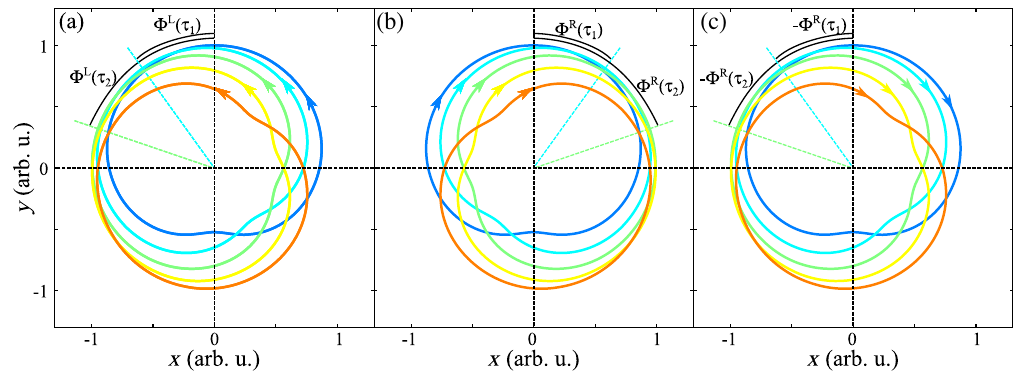
FIG. 8. Evolution of a bicircular field with intensity ratio r ¼ 0 . 1 as a function of the delay between the two ω − 2 ω components, increasing from blue to red by steps of δτ ≈ 133 as. (a) The fundamental field is left polarized. (b) The fundamental field is right polarized. (c) Alternative geometry for tomographic inversion, switching the sign of the rotation angle Φ R to obtain the mirror image of the photoelectron angular